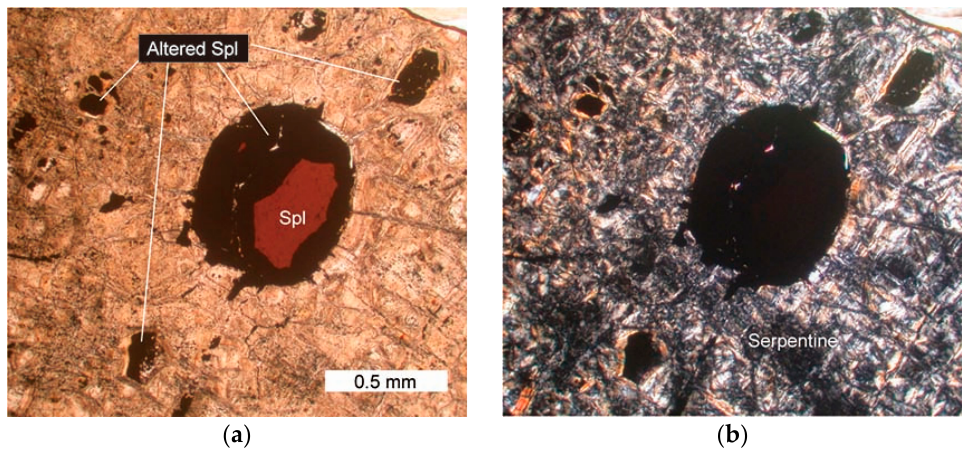
Figure 5. Photomicrograph of the dunite sample (M42DH). ( a ) Plane-polarized light. ( b ) Cross-polarized light. Reddish brown-colored primary spinel is observed in an altered spinel (Spl). Fully altered spinels, now magnetites, occur in totally serpentinized olivine matrix.